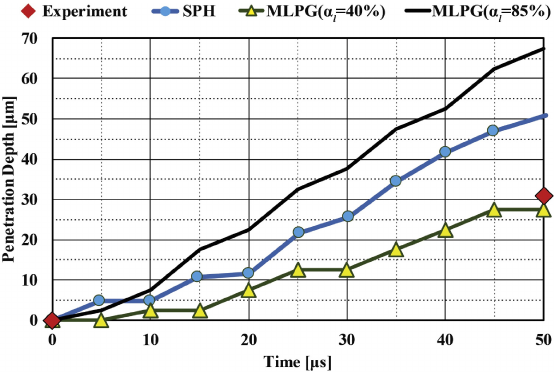
Figure 8. Graph given by [13] demonstrating the numerically calculated penetration depth against experimental data points [10] where α l in this plot indicates the absorption coefficient. Reprinted from [13], Copyright (2020), with permission from Elsevier under License Number 4835890957650.